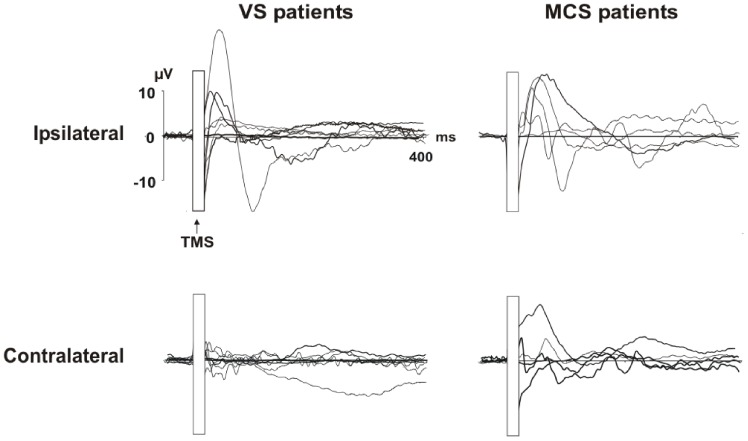
Individual TEPs recorded from both hemispheres for the two groups of patients: VS patients are shown in the left column, and MCS patients are shown in the right column.TEPs recorded over the stimulated hemisphere are displayed in the upper row, and TEPs recorded over the contralateral hemisphere are in the lower row.